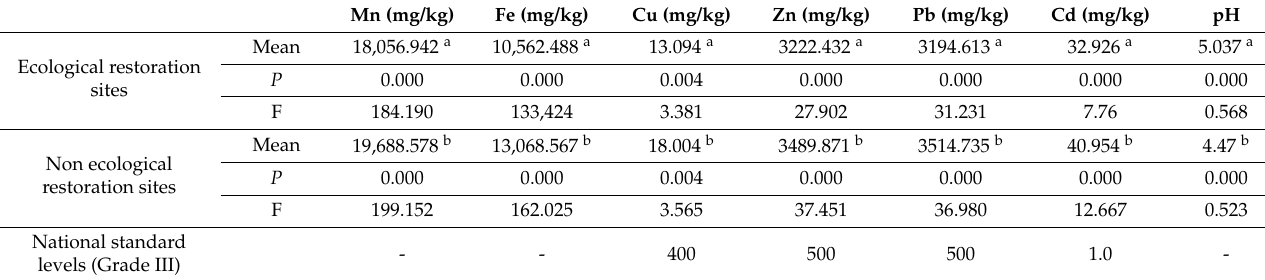
Table 2. Soil content of heavy